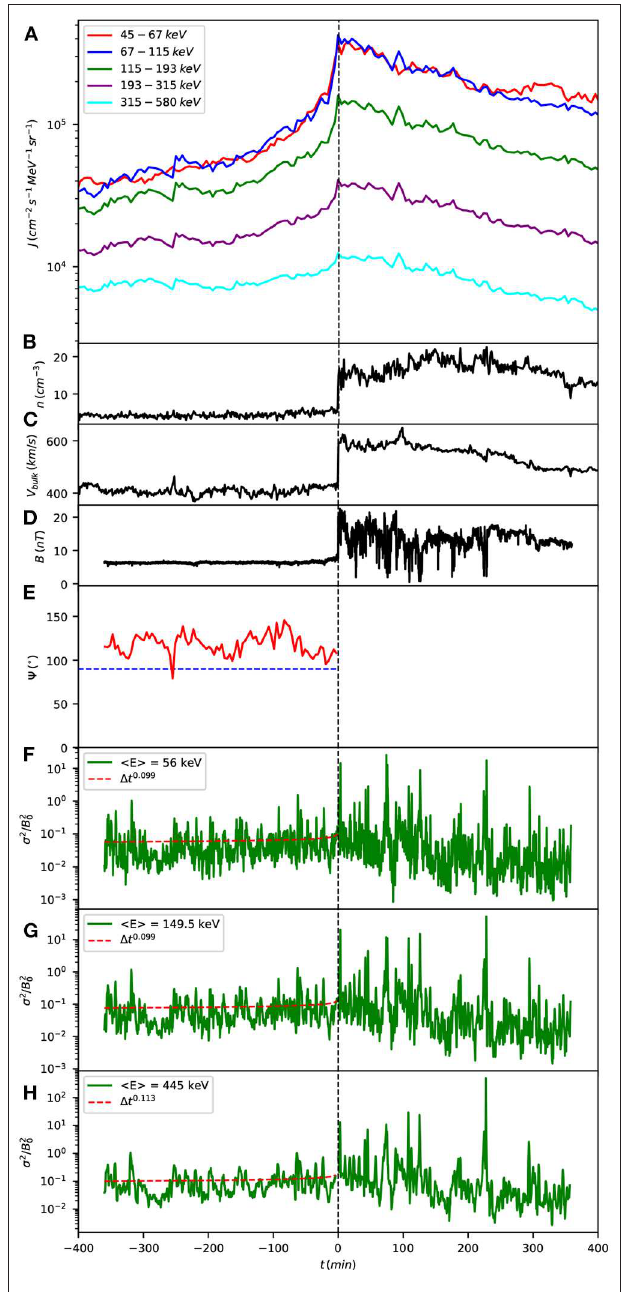
FIGURE 1 | Measured quantities for the shock crossing observed by ACE on 23 April 2002. From top to bottom: (A) differential flux J of energetic particles measured by LEMS-30 in the energy channels from 45–67 to 315–580 keV, see colors in the legend; for this event only, the particle fluxes in the energy channel 45–67 keV of LEM-30 are not available, so we are showing the flux measured by LEMS-120. (B) Proton number density; (C) bulk velocity in the spacecraft frame; (D) magnetic field amplitude; (E) angle ψ between the magnetic field and the radial direction; (F,G,H) magnetic variances normalized to the average magnetic field B 0 , computed on the spatial scale corresponding to the proton gyroradius at the mean energies of three energy channels, as indicated (see